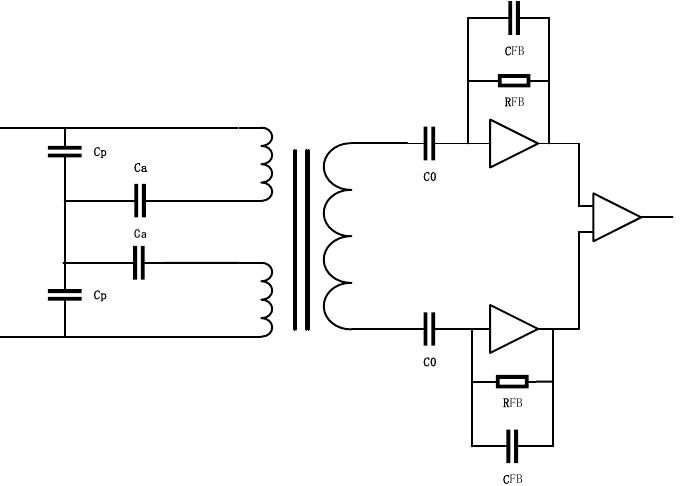
Figure 4. Analog front ‐ end and AC ‐ amplifier circuits.